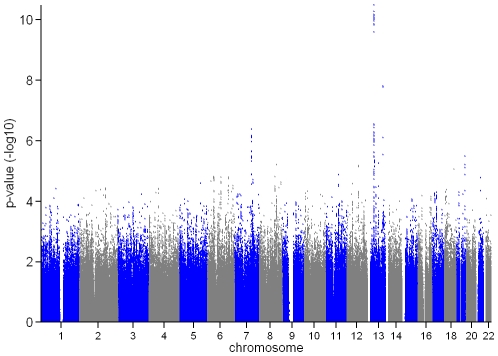
Manhattan plot of the ALSPAC and GOOD genome-wide meta-analysis of BMDC.